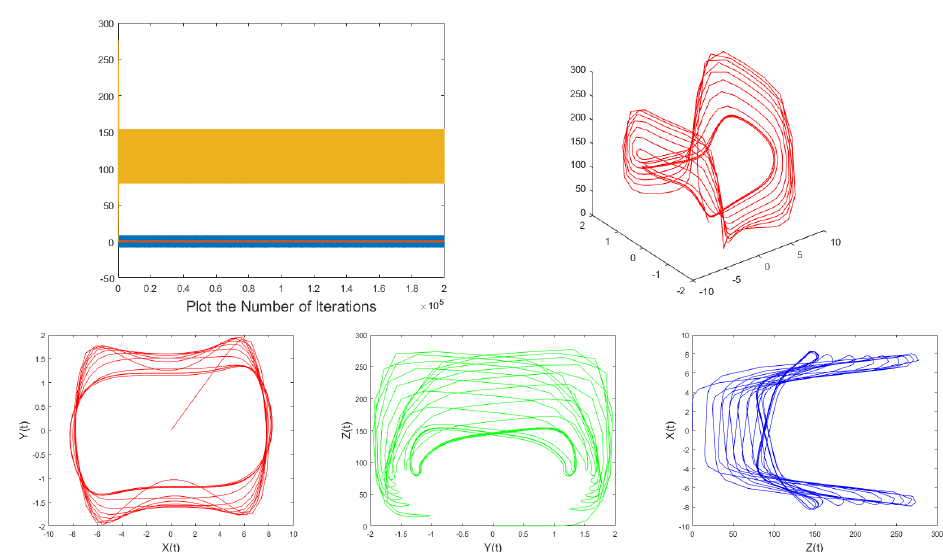
Fig. 5 Unstable trajectories (limit cycle) which are away from the origin in the system D 26 , 93 , 36 [ 5 ] . For the system D 9 , 7 , 54 [ 16 ] , the eigenvalues of the Jacobian are − 63 , − 54 and 54 where real part of the eigenvalues are not all negative and hence the equilibrium point ( 0 , 0 , 0 ) is unstable. The trajectories are shown in Fig.6 with many initial values taken from the neighbourhood of the equilibrium point ( 0 , 0 , 0 ) .